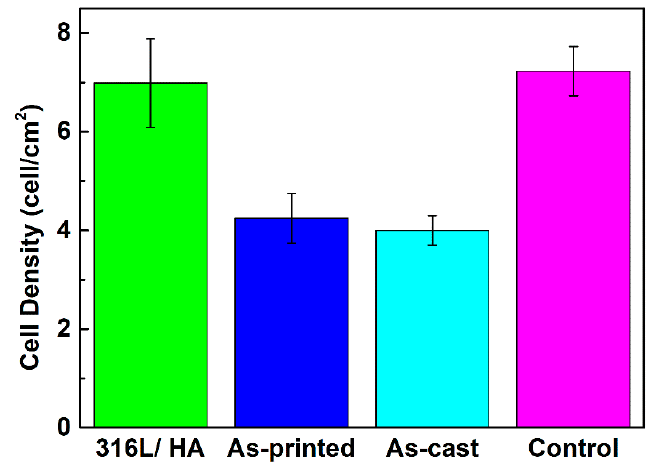
Figure 14. The cell densities after 120 h of culturing.